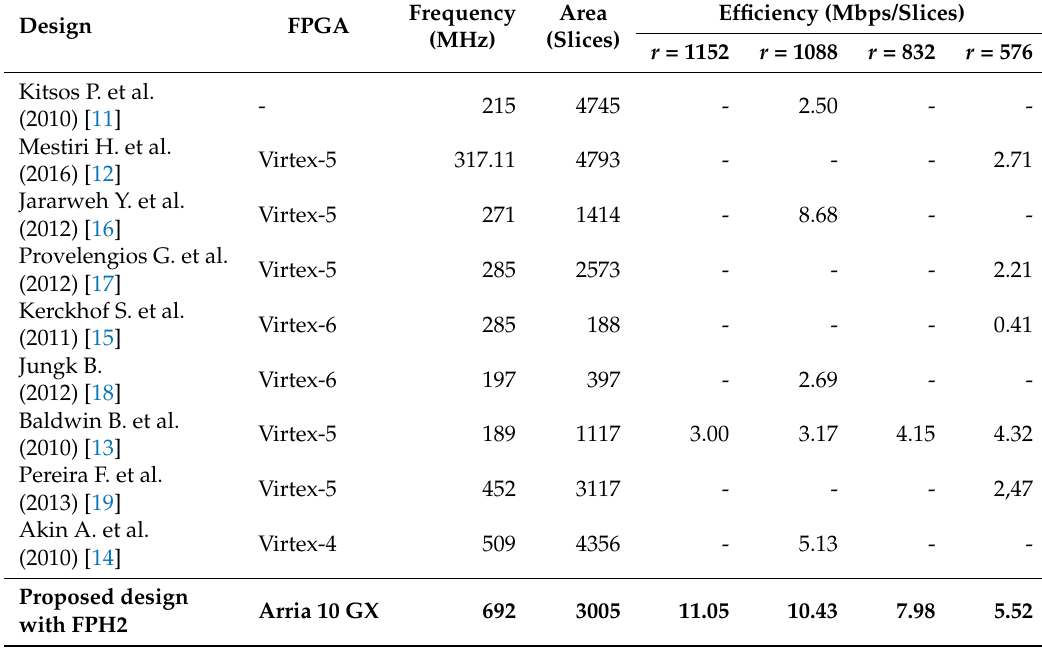
Table 8. Efficiency results and comparison. With bold is ours experimental